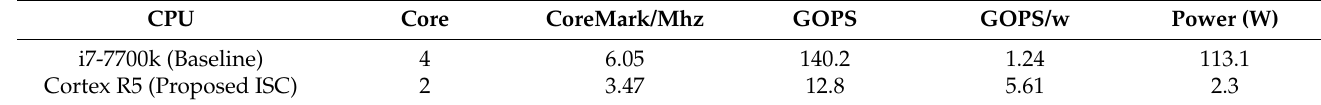
Table 4. The specification comparison of processors in baseline and proposed ISC.